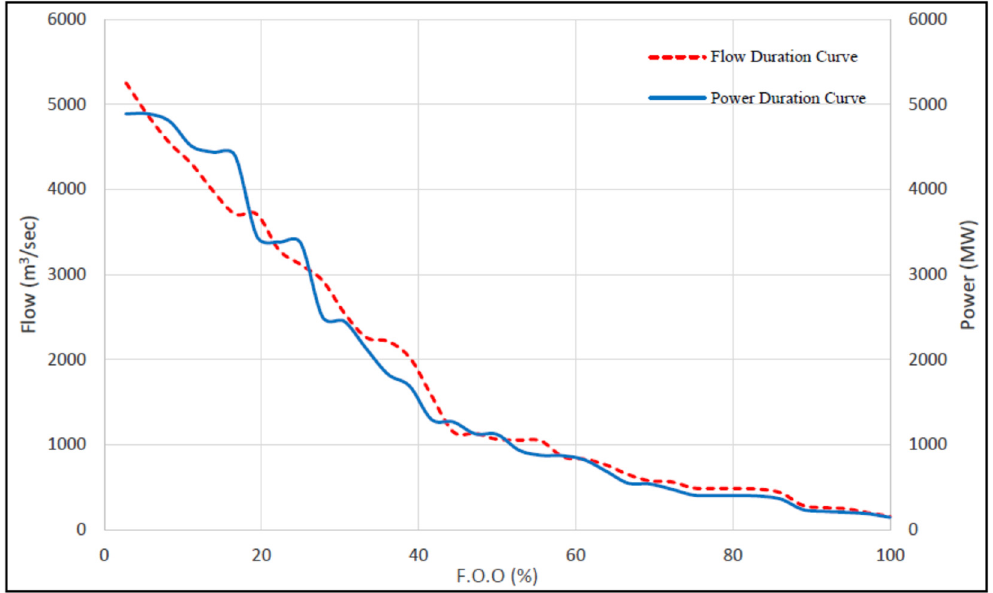
Figure 39. Flow and Power Duration curves of Application year 2025.